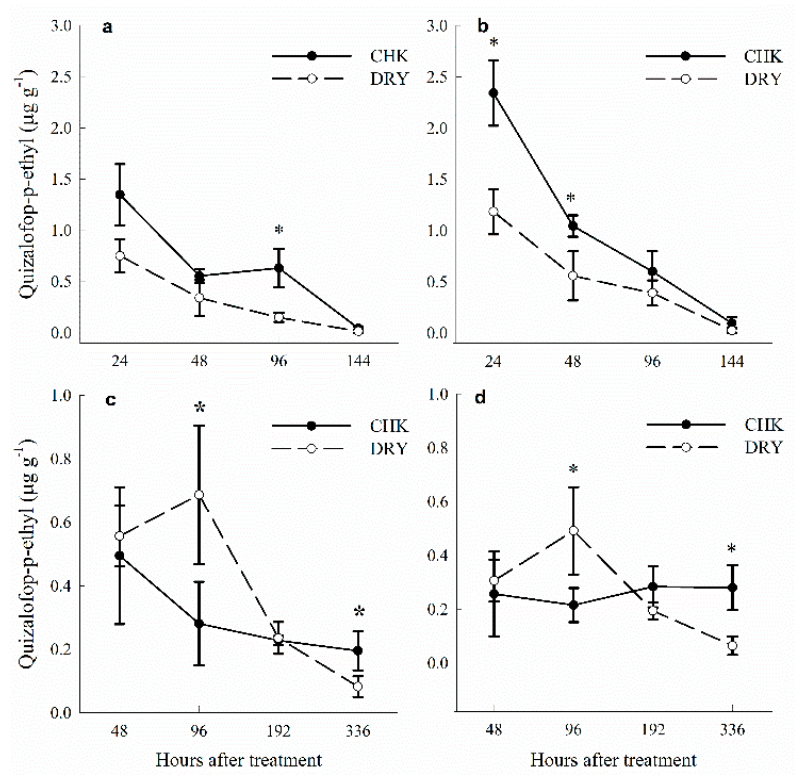
Figure 6. Quizalofop-p-ethyl concentration (µg g − 1 ) unabsorbed ( a , c ) and absorbed ( b , d ) of Eragrostis plana populations (CHK–no stress and DRY-drought) at 24, 48, 96, and 144 h ( a , b ) and 48, 96, 192, and 336 h ( c , d ) after applying quizalofop. Error bars represent a 95% confidence interval. * t -test ( α = 0.05).